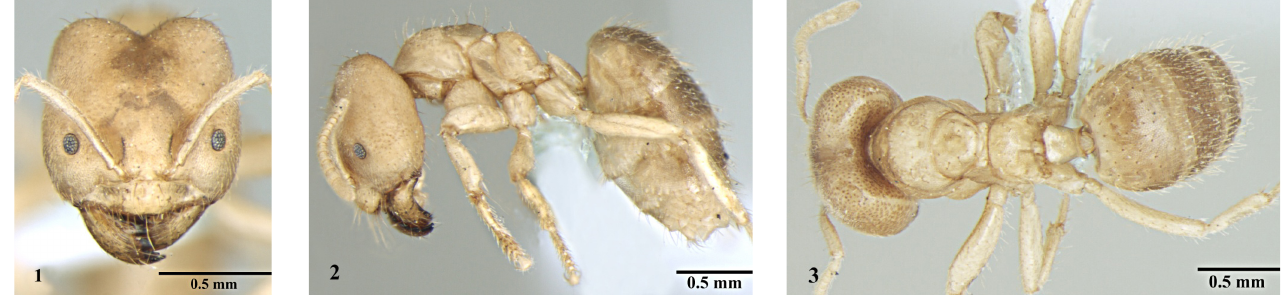
Fig. 1-3. Pseudolasius diversus sp. n ., major worker 1) head, full face view; 2) Body, lateral view; 3) body, dorsal view.